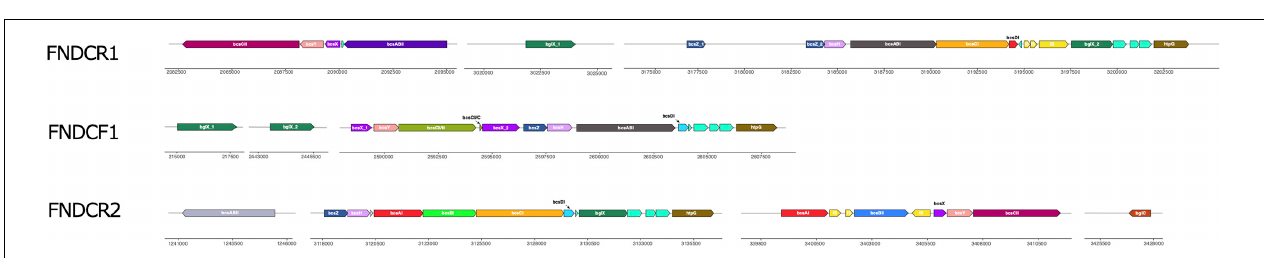
FIGURE 9 | Cellulose biosynthesis operons of the present strains. The figure portrays the operon structure for genes involved in cellulose biosynthesis. The structure was drawn based on results obtained for gene annotation ( Supplementary Table 1 ). Rectangles with arrowheads represent regions that encode genes, open reading frames (ORFs), or transposons (ISs). The arrowhead direction shows the DNA strand orientation (forward/reverse). The numbers represent the genomic positions in the chromosomes. Colors correspond to the encoded genes or ISs. Those without names are the predicted ORFs.